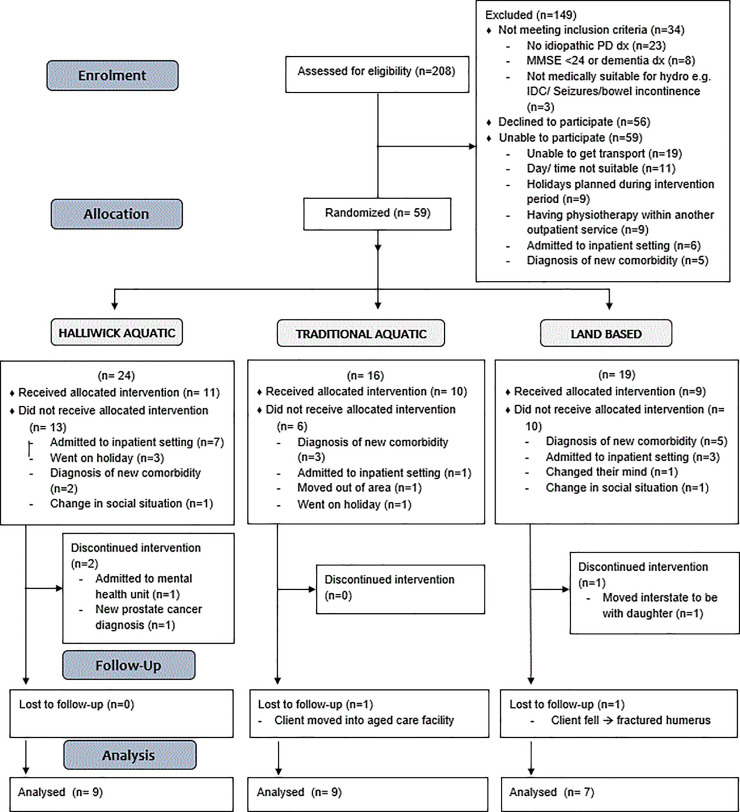
Consort diagram.